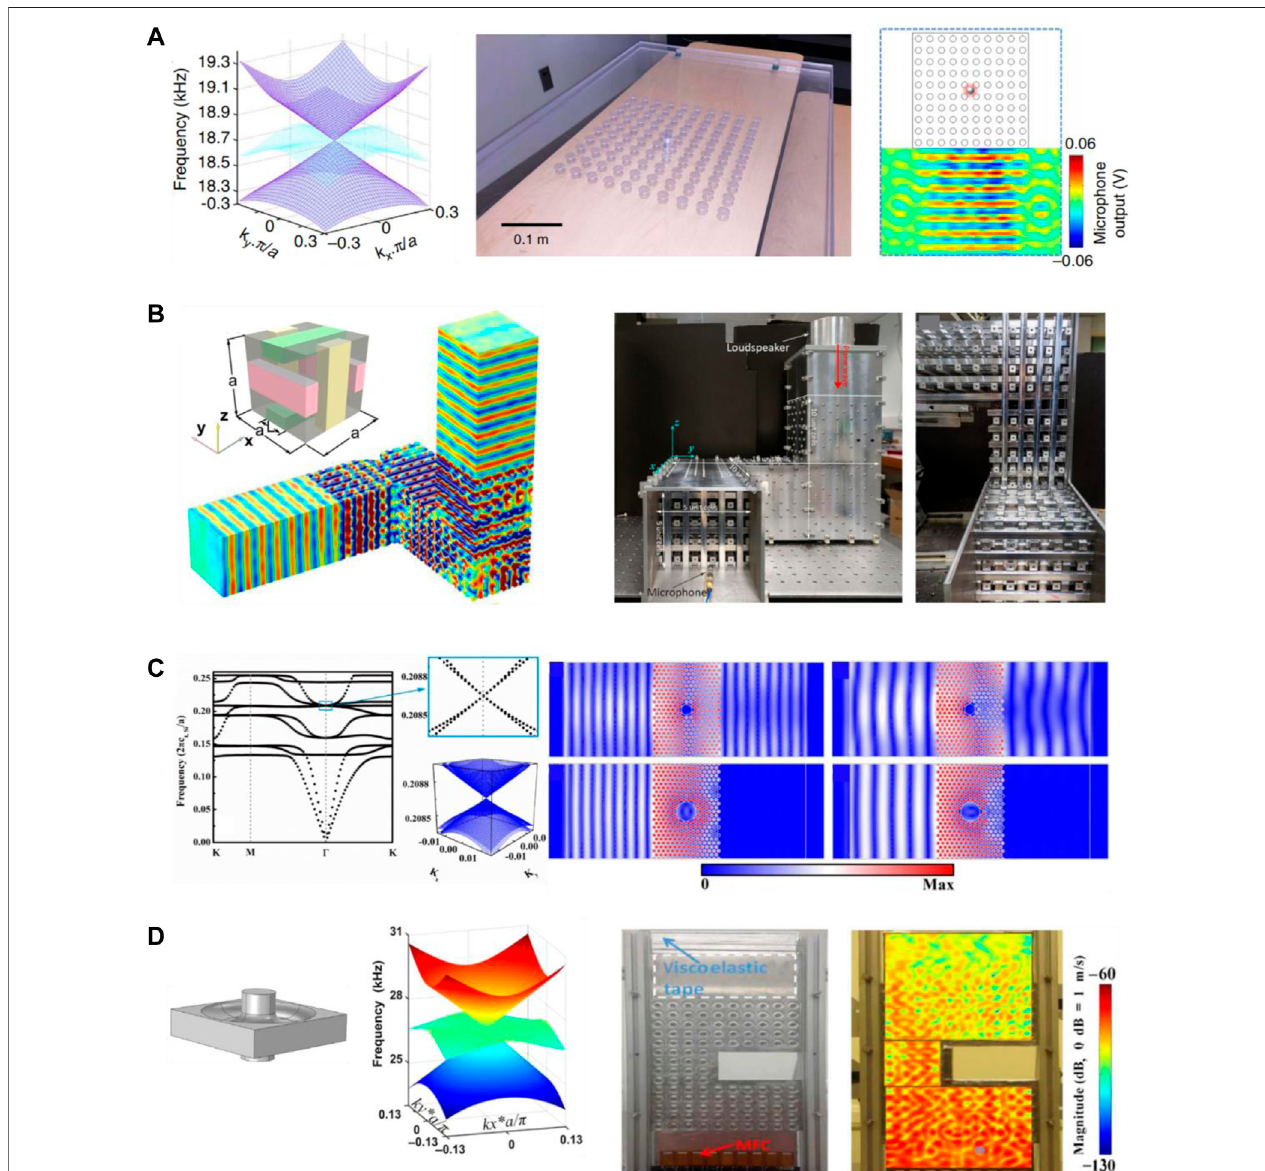
FIGURE6|(A) Left:enlargedviewofdispersionsurfacesneartheDirac-like coneofthePnCconsistingofasquarelatticeofblindholes.Middle:photographofthe fabricated sample. Right: measured pressure fi eld radiated by an acoustic point source embedded in PnC, showing the directive emission behavior at the Dirac-point frequency.ReproducedwithpermissionfromRef.[166]. (B) Left:simulatedpressure- fi elddistributionwhenabendingwaveguideis fi lledwith3Dcubic-latticePnCwitha Dirac-like cone. The inset shows the unit cell comprising three aluminum rods in air. Right: photograph of the fabricated bending waveguide. Reproduced with permission from Ref. [174]. (C) Left: band structure for in-plane modes of a 2D triangular-lattice PnC consisting of rubber cylinders embedded in silicon host, and the enlarged view of the double Dirac cone. Right: simulated displacement- fi eld distributions for the 2D PnC embedded with the steel cylinders to achieve transmission preserving plane wave characteristic (upper) and total re fl ection (lower). Different columns represent the incident longitudinal and transverse waves, respectively. Reproduced with permission from Ref. [163]. (D) Left: schematic of the tapered unit cell of a square-lattice PnC. Middle: enlarged view of dispersion surfaces near the Dirac-like cone. Right: photograph of U-shaped waveguide channel fi lled with the PnC, and measured amplitude of out-of-plane velocity at the Dirac-point frequency. Reproduced with permission from Ref. [165].